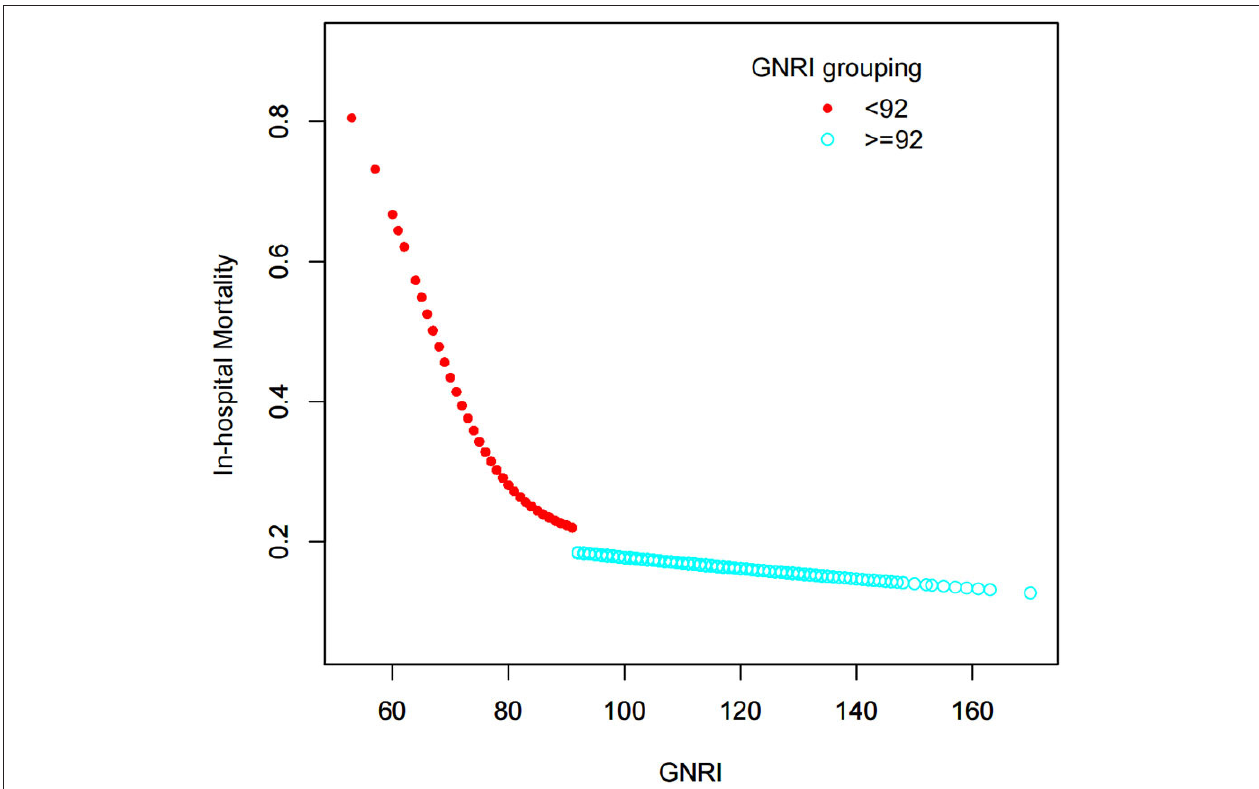
FIGURE 3 | Relationship between GNRI and death during hospitalization. In accordance with the GNRI cutoff of 92, the curve fitting equation is performed again. Evident differences can be observed in the slopes of the two equations before and after the cutoff value.